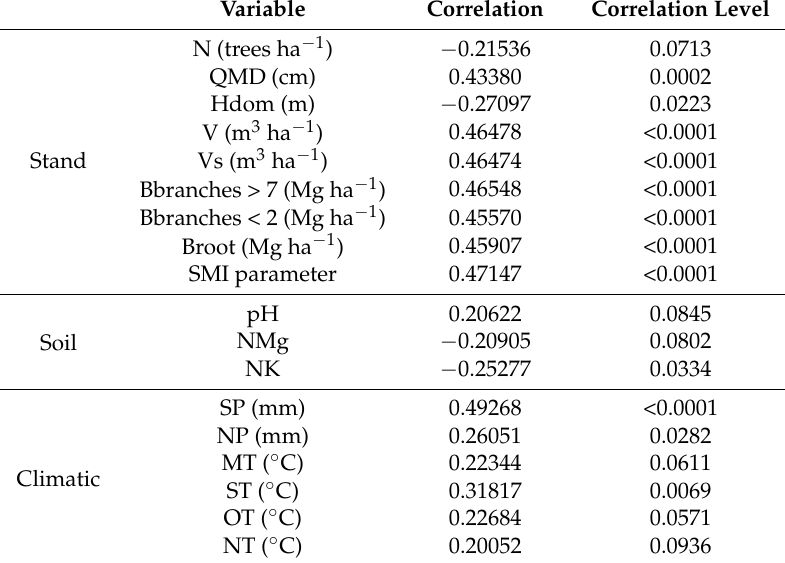
Table 3. Results indicating significant correlation levels between stand, site, soil and climatic variables and total mushroom